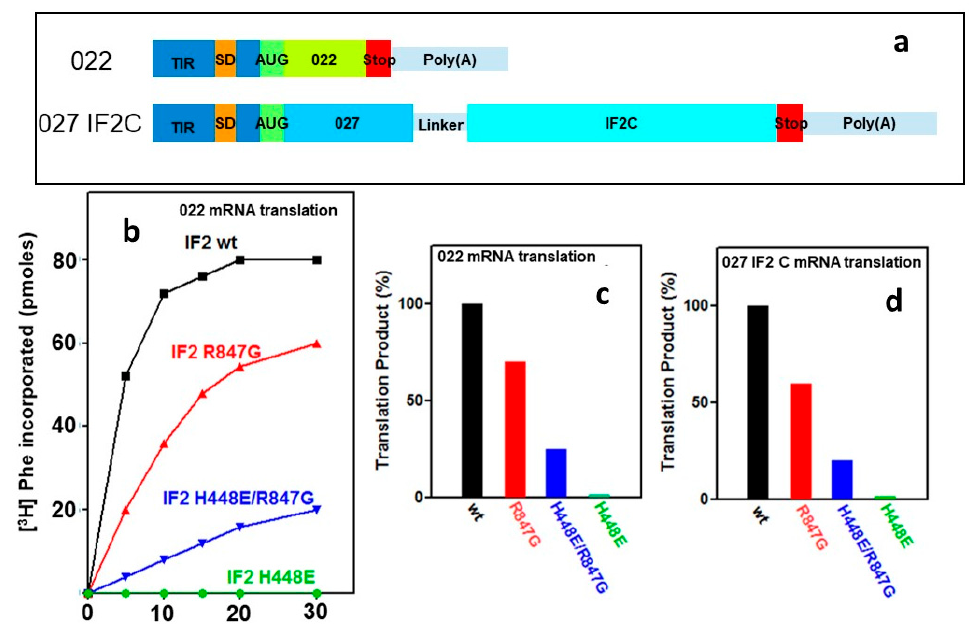
Figure 8. mRNA translation in the presence of IF2 wt and IF2 mutants. ( a ) Schematic representation of the mRNAs used in the translation tests. The corresponding sequences are reported in Supplementary Materials (Figure S3a,b). Translation of mRNA in cell free systems containing IF2 wt (black), IF2 R847G (red), IF2 H448E/R847G (blue), and IF2 H448E (green); ( b ) Time course of [ 3 H] phenylalanine incorporation into acid-insoluble product under the direction of model 022mRNA [45]. The incubation was carried out at 37 °C for the indicated times or for 45 min (panel ( c )); ( d ) the level of 027IF2C mRNA translational was quantified by ELISA using monoclonal antibodies directed against IF2C, as described [45]. In panels ( c , d ), the translational level obtained in the presence of the IF2 mutants is expressed as % of the level obtained with IF2 wt. No detectable translation was observed in the absence of IF2.